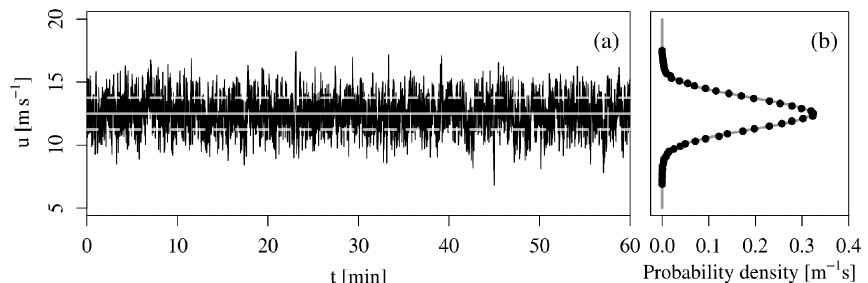
Figure 1. Exemplary Gaussian wind time series. (a) Main wind velocity component u ( t ), including mean ± 1 standard deviation (dashed lines). (b) Corresponding histogram and Gaussian fit.